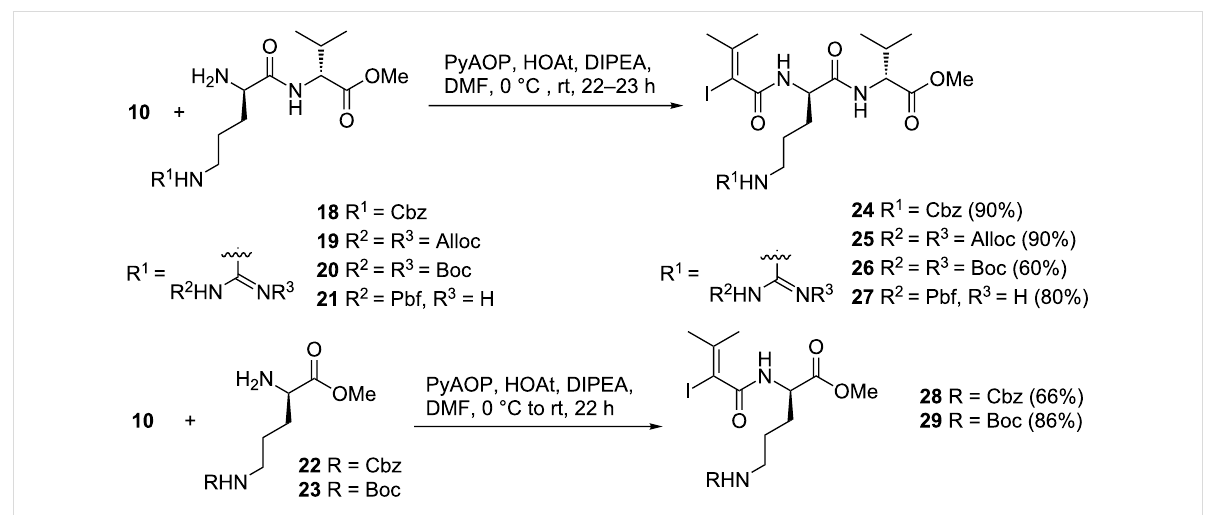
flexibility towards the end of the total synthesis when the guani- dine group has either to be liberated by the removal of the protecting groups or used for the introduction to the correspond- ing ornithine